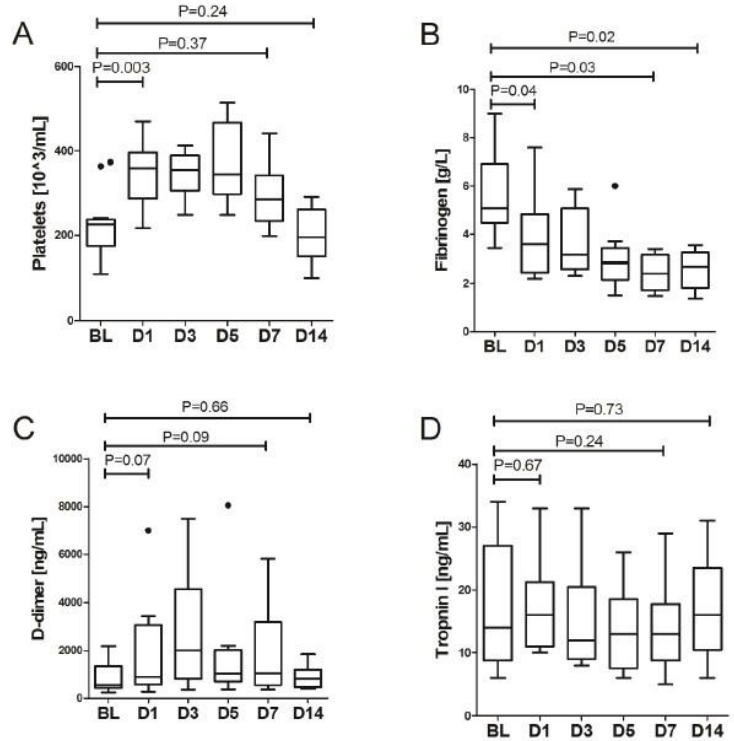
Figure 3. The change of concentration of selected parameters in the blood in subsequent days after LDRT: ( A ) platelets, ( B ) fibrinogen, ( C ) D-dimers, ( D ) troponin. Bold dots denote